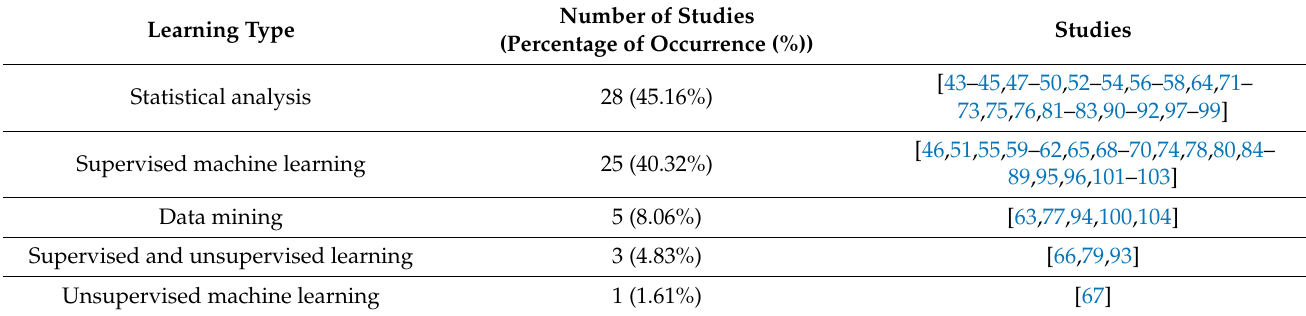
Table 7. Distribution of student outcomes predictive models per learning type.